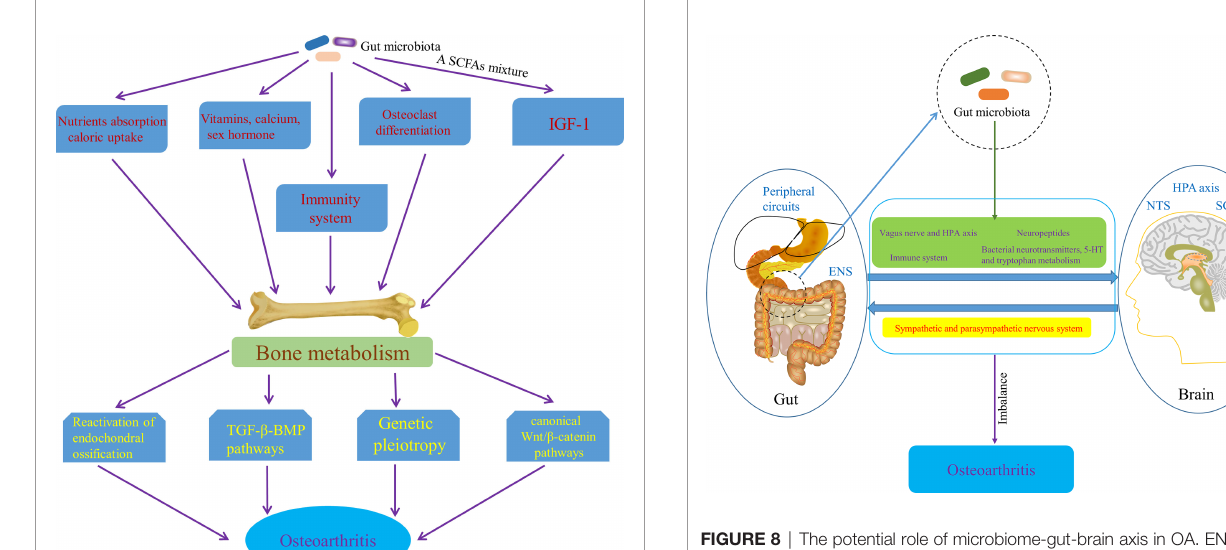
FIGURE 8 | The potential role of microbiome-gut-brain axis in OA. ENS, enteric nervous system; HPA axis, hypothalamic-pituitary axis; NTS, nucleus tractus solitaries; SCN, hypothalamic suprachiasmatic